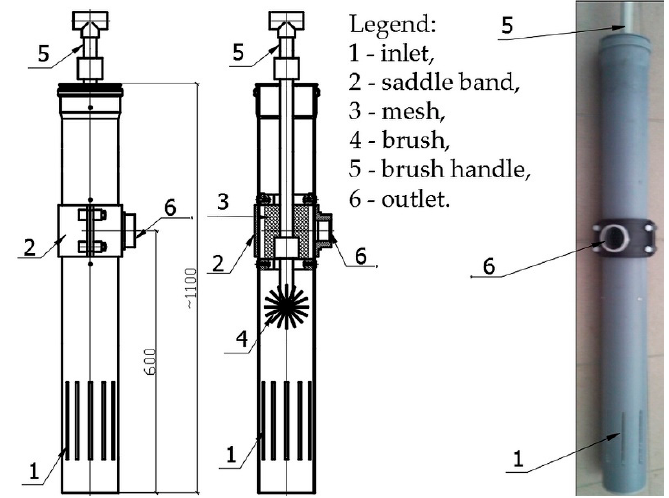
Figure 5. Effluent filter—vertical section and side views.